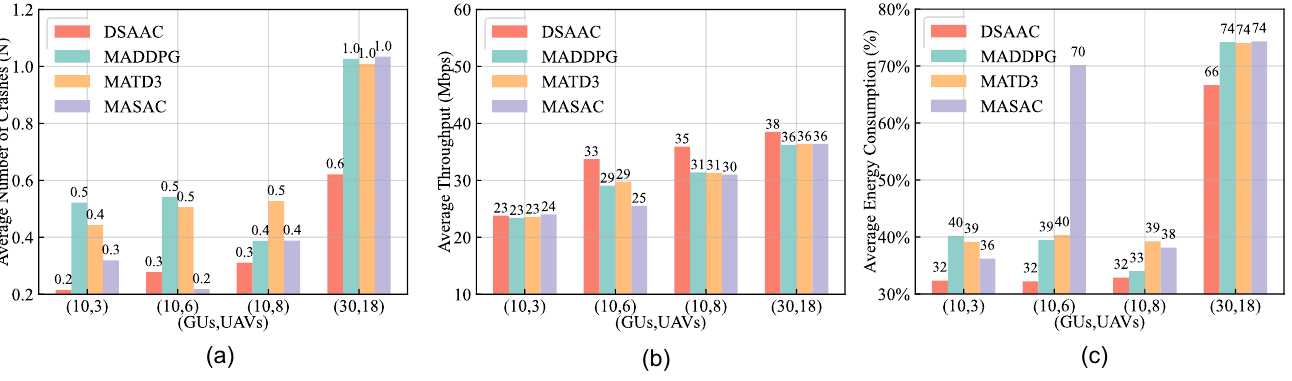
Figure 9. Performance comparison of different number of UAVs: ( a ) Average number of crashes; ( b ) Average system throughput; ( c ) Average energy